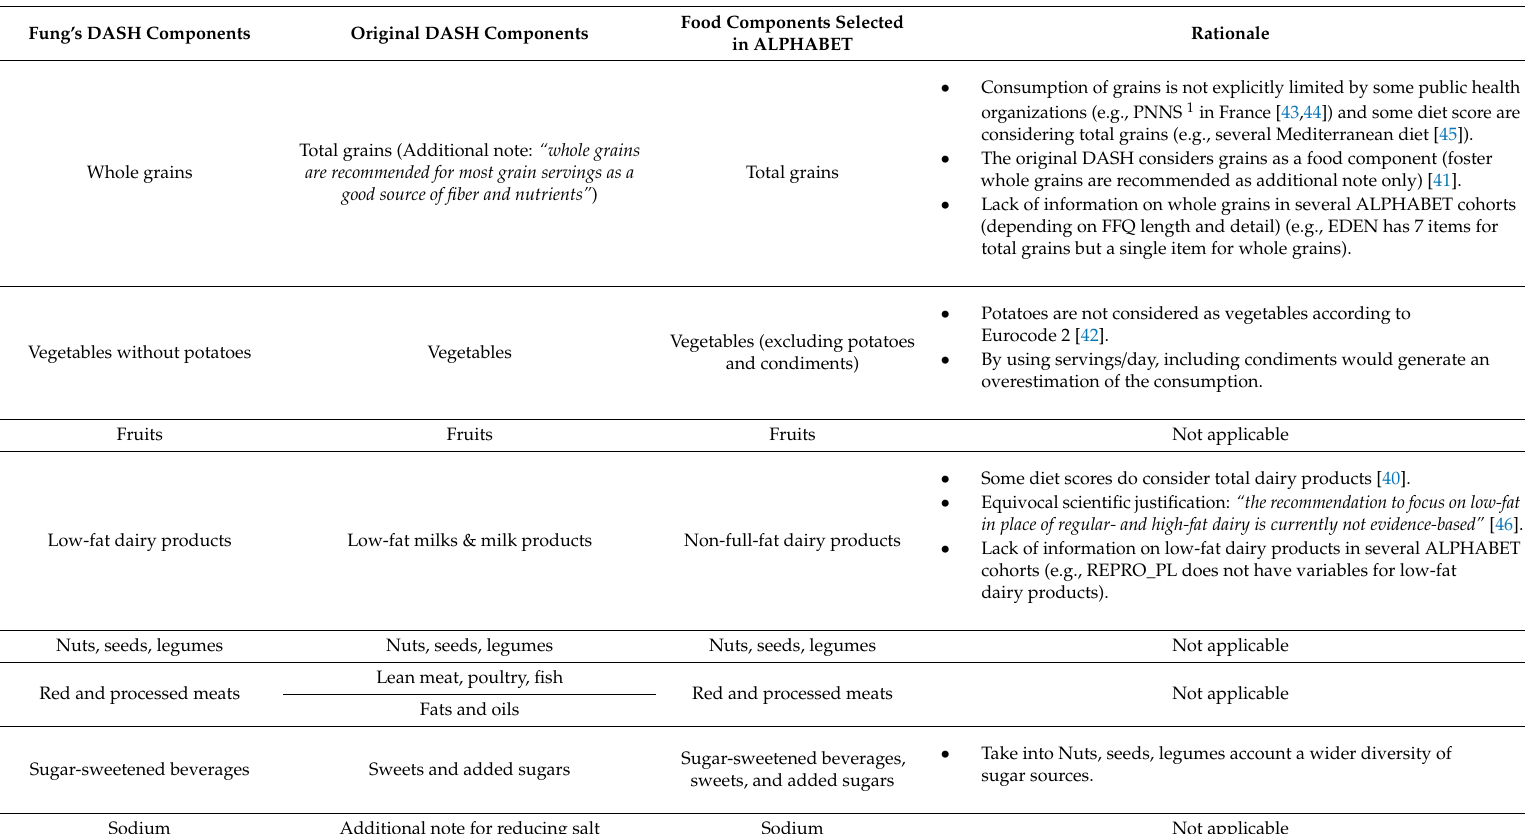
Table 3. Final food component